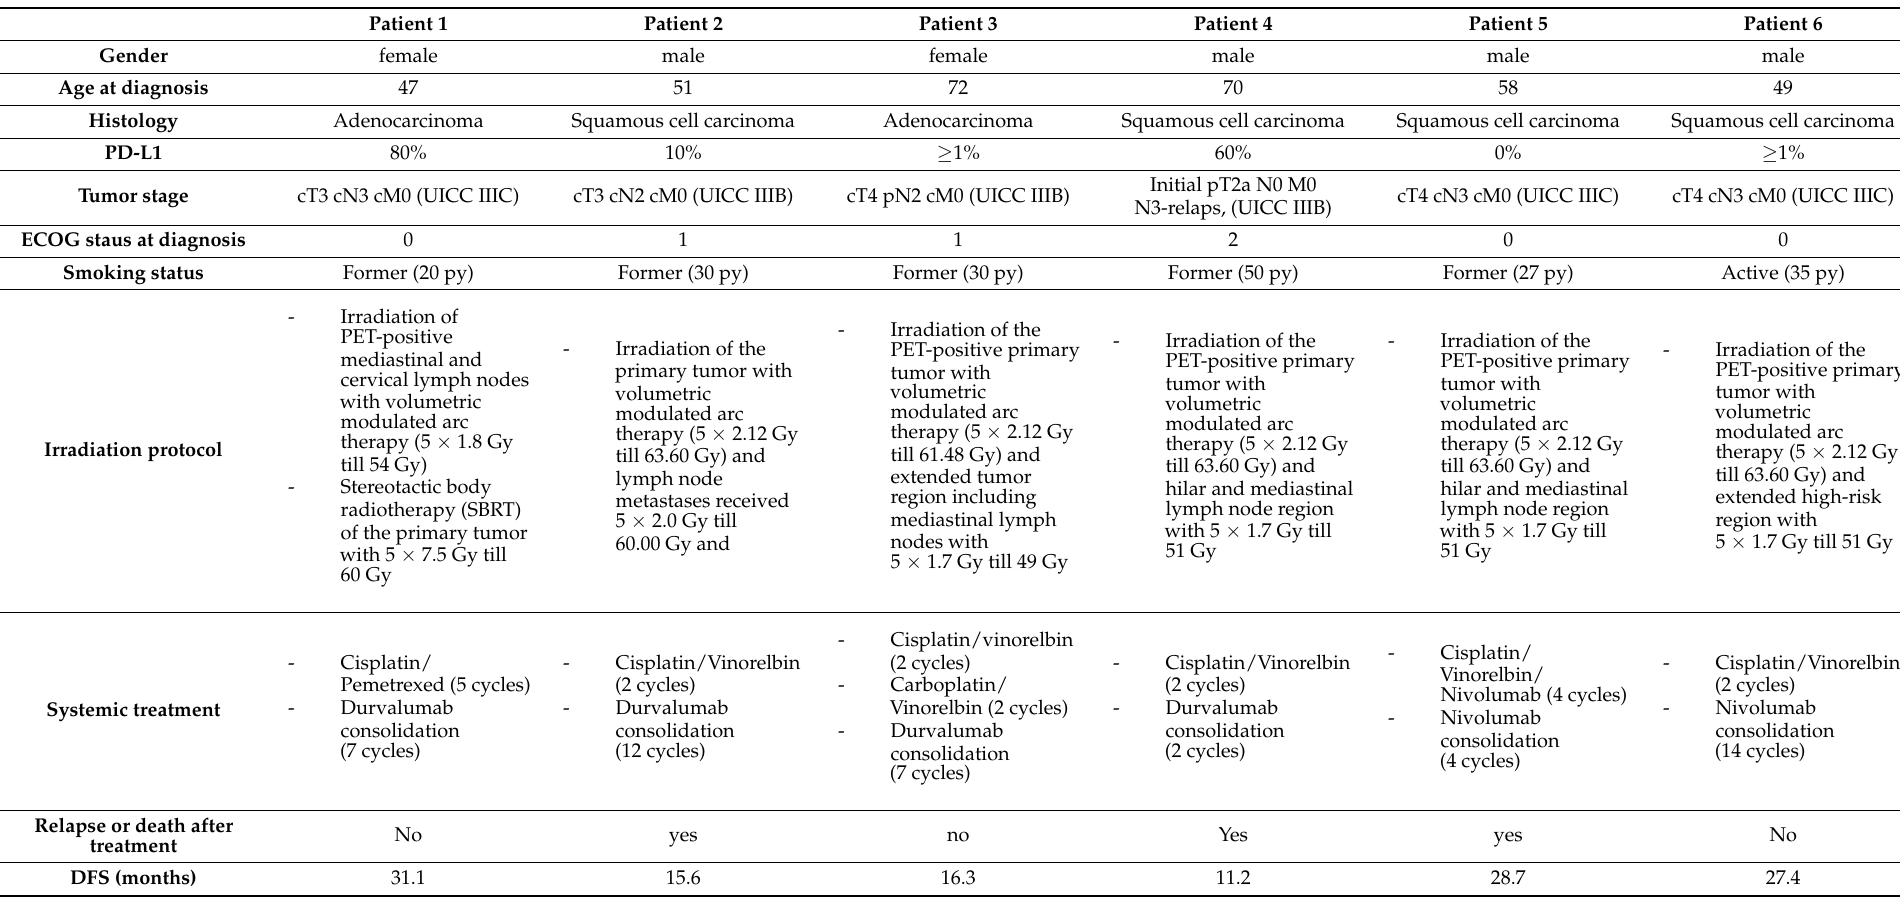
Table 1. The table shows patients baseline characteristics and treatment modalities. PD-L1 (Programmed Death Ligand 1, ≥ 1% indicates a positive case with an expression of lower than 5%), ECOG (Eastern Cooperative Oncology